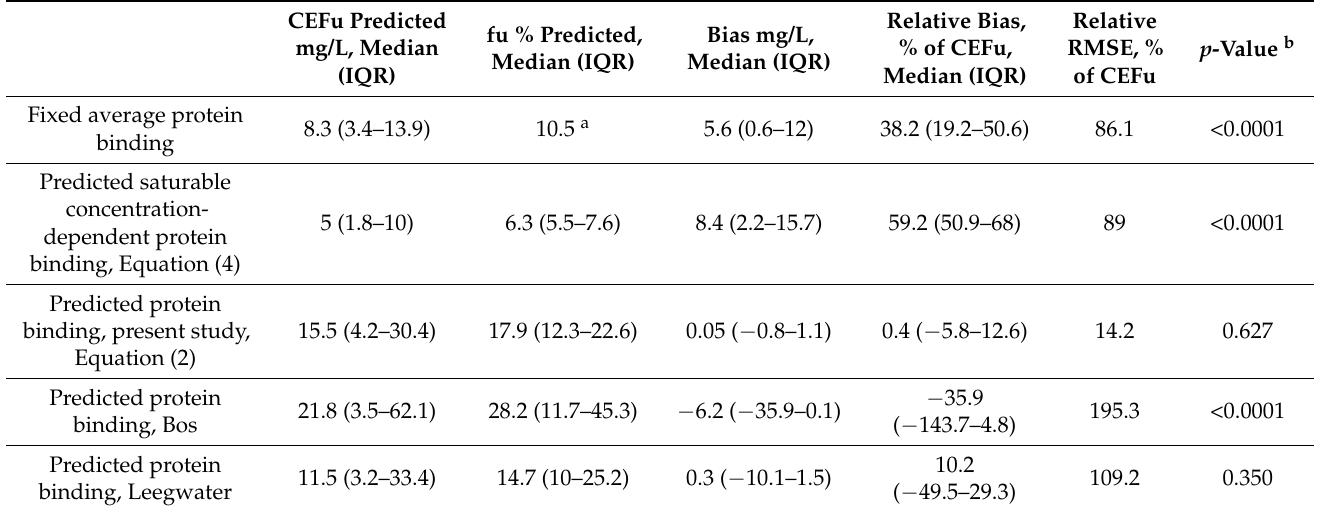
Table 2. Agreement between measured and predicted unbound concentration of ceftriaxone.